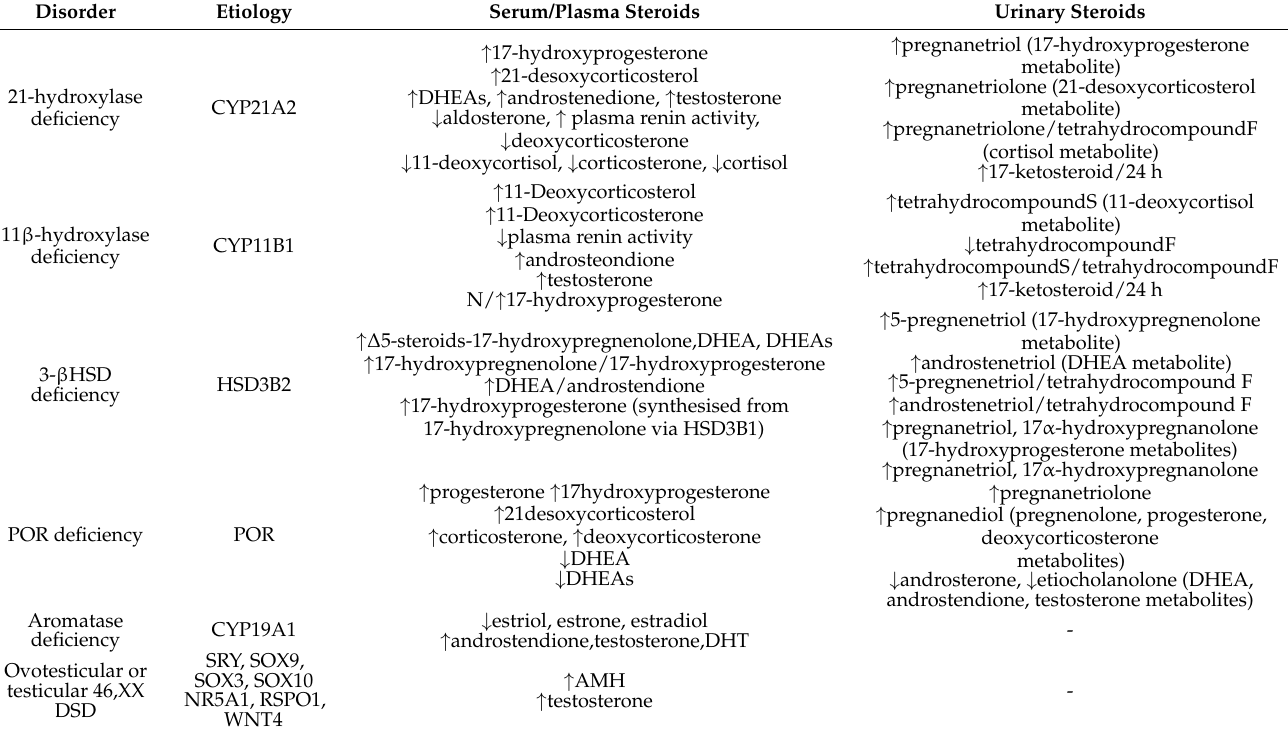
Table 1. Serum/plasma and urinary steroids in different disorders of 46,XX DSD